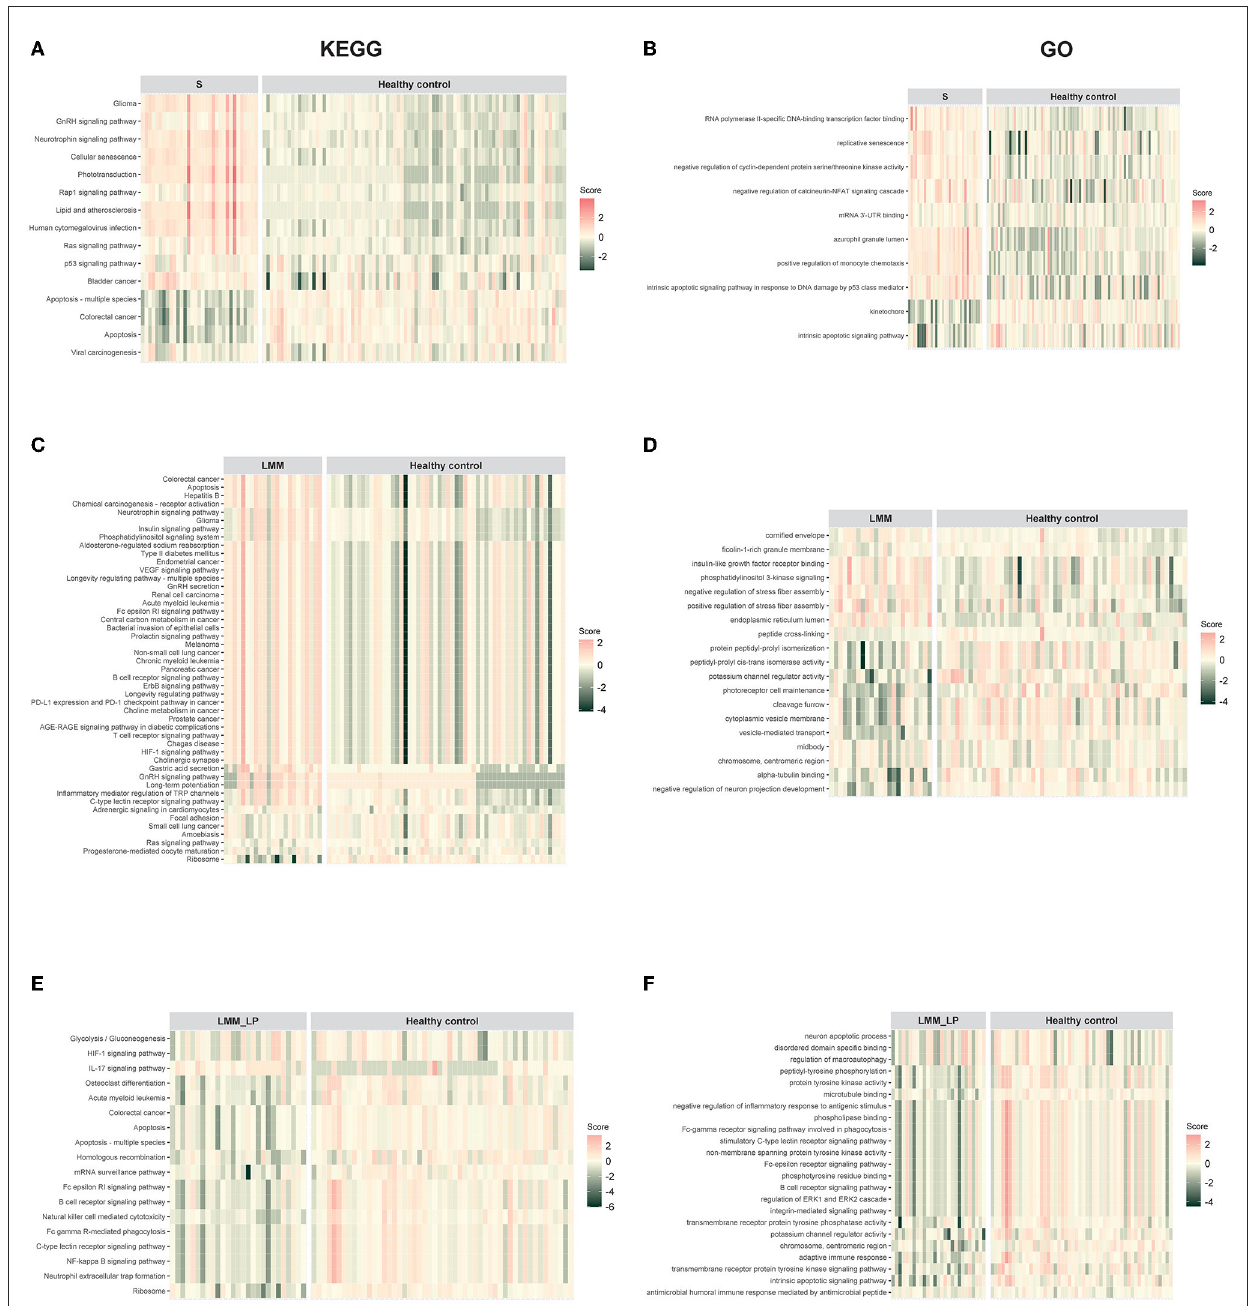
FIGURE1 Pathway enrichment analysis for sarcopenia (S), low muscle mass (LMM), and low muscle mass with physical performance (LMM_LP) by unsupervised hierarchical clustering. (A) KEGG and (B) GO pathways enrichment analysis for sarcopenia (S) vs. healthy controls. (C) KEGG and (D) GO pathways enrichment analysis for low muscle mass (LMM) vs. healthy controls. (E) KEGG and (F) GO pathways enrichment analysis for low muscle mass with physical performance (LMM_LP) vs. healthy controls. The enrichment agglomerated z-score was calculated for each enriched term per